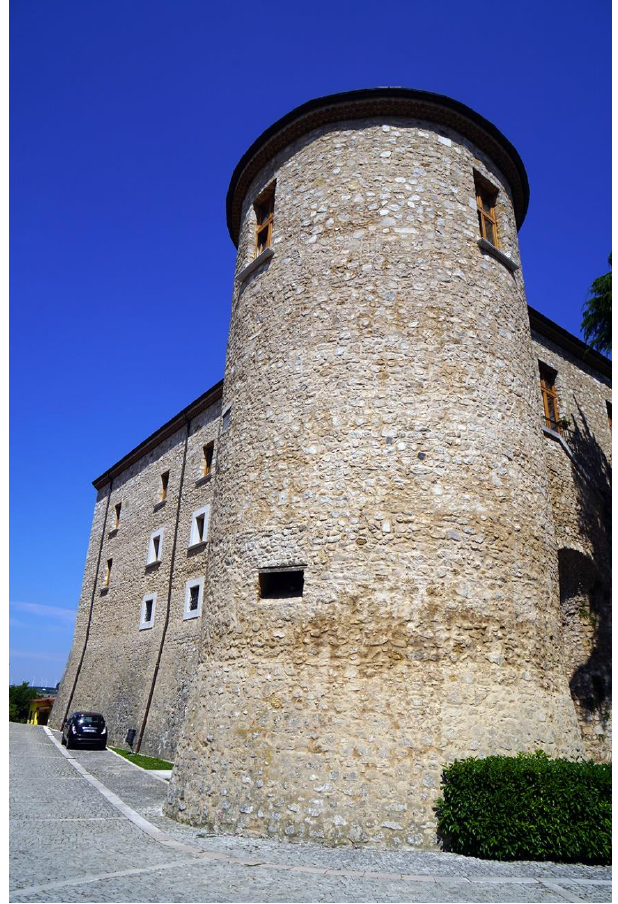
Figure 75. Torella dei Lombardi: the restored castle of Ruspoli di Candriano (photos by [35,36]).